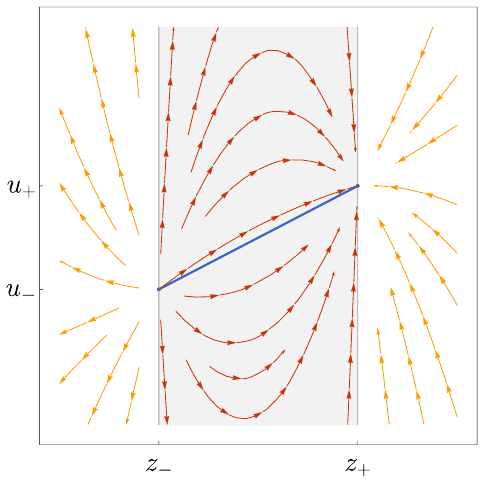
Figure 2 . Modular (cid:13)ow (red) for a single interval (blue) in BMSFTs. The causal domain of dependence (gray) and the behavior of the modular (cid:13)ow near the endpoints di(cid:11)ers from that of CFTs. We also show the modular (cid:13)ow generated by (cid:22) (cid:16) in